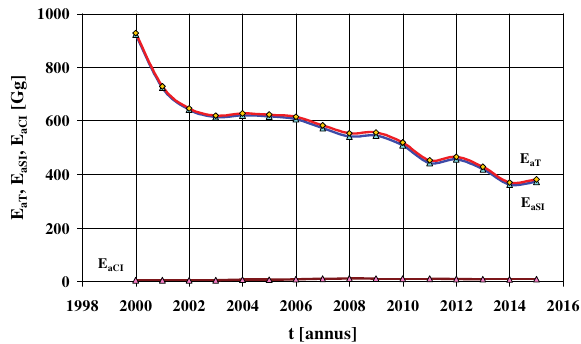
Fig. 9. National annual emission of nitrogen oxides from passenger